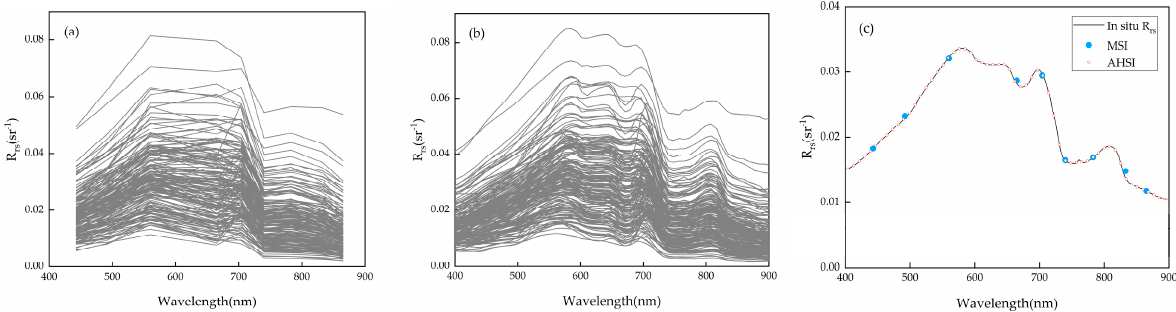
Figure 5. MSI ( a ) and AHSI ( b ) equivalent reflectance spectra and the comparison with average in situ reflectance ( c ).